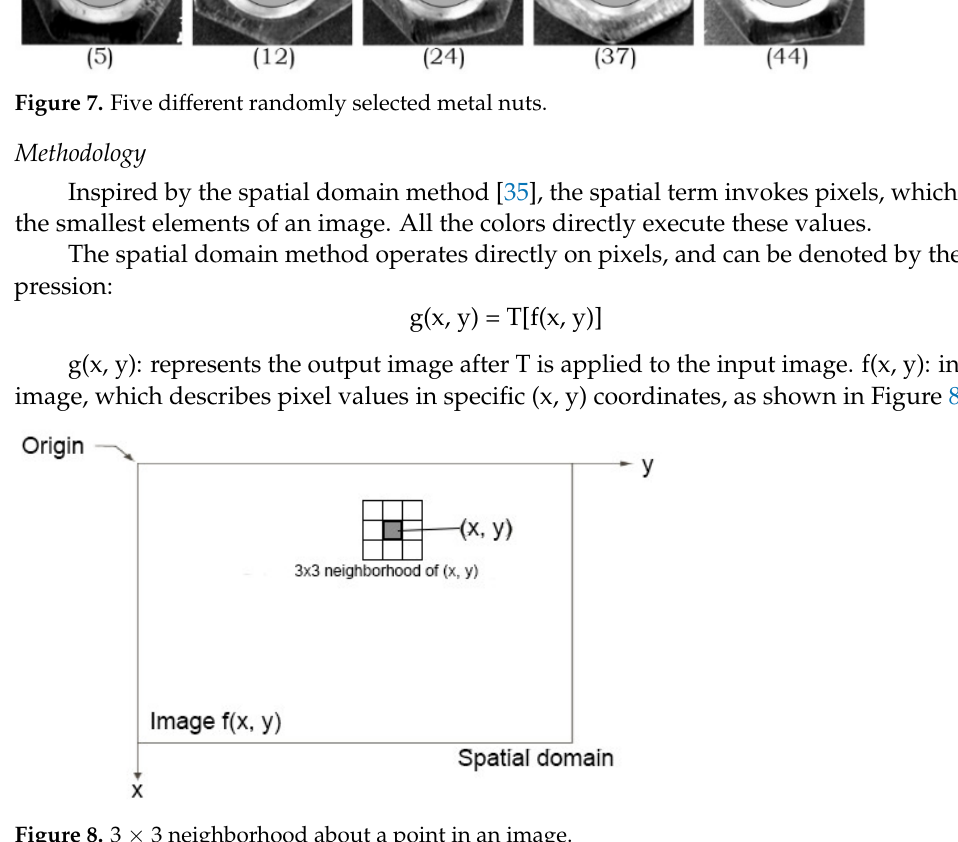
Figure 7. Five different randomly selected metal nuts.